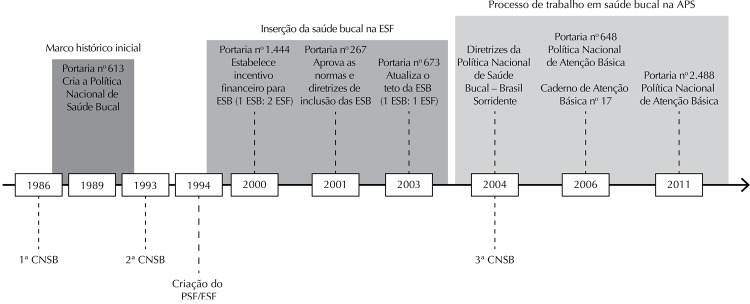
Linha do tempo, identificando os momentos e normatizações que marcam o incentivo às mudanças no processo de trabalho em saúde bucal na Atenção Primária à Saúde no Brasil.